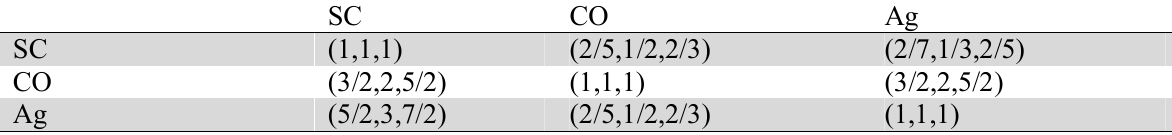
The Evaluation Matrix Relevant to the Work Factor